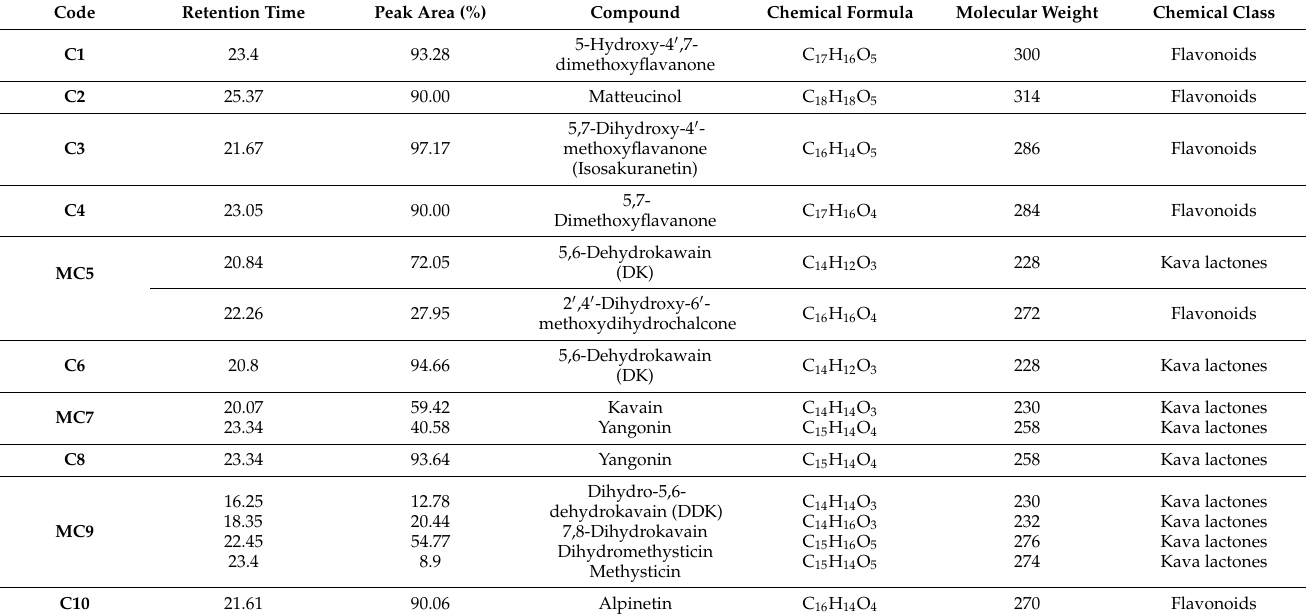
Table 1. Identification of isolated compounds from EtOAc extract of kava root by GC–MS, ESI–MS, 1 H and 13 C